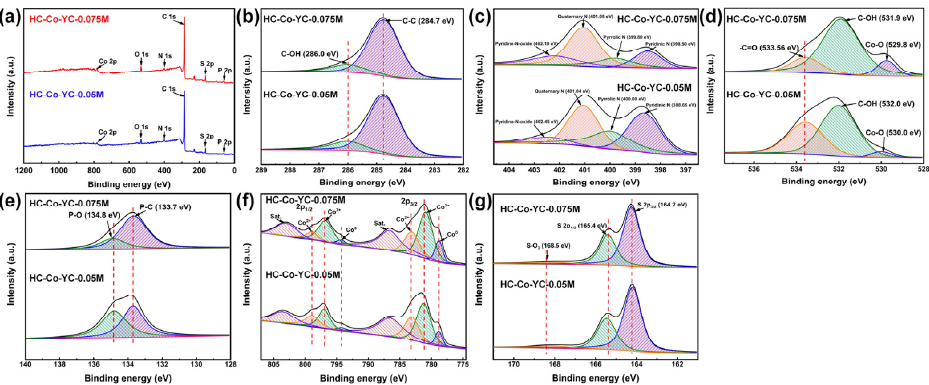
Figure 6. Surface chemical valence states of HC–Co–YC–0.075M/S: ( a ) XPS survey, ( b ) C 1s spectrum, ( c ) N 1s spectrum, ( d ) O 1s spectrum, ( e ) P 2p spectrum, ( f ) Co 2p spectrum, and ( g ) S 2p spectrum.